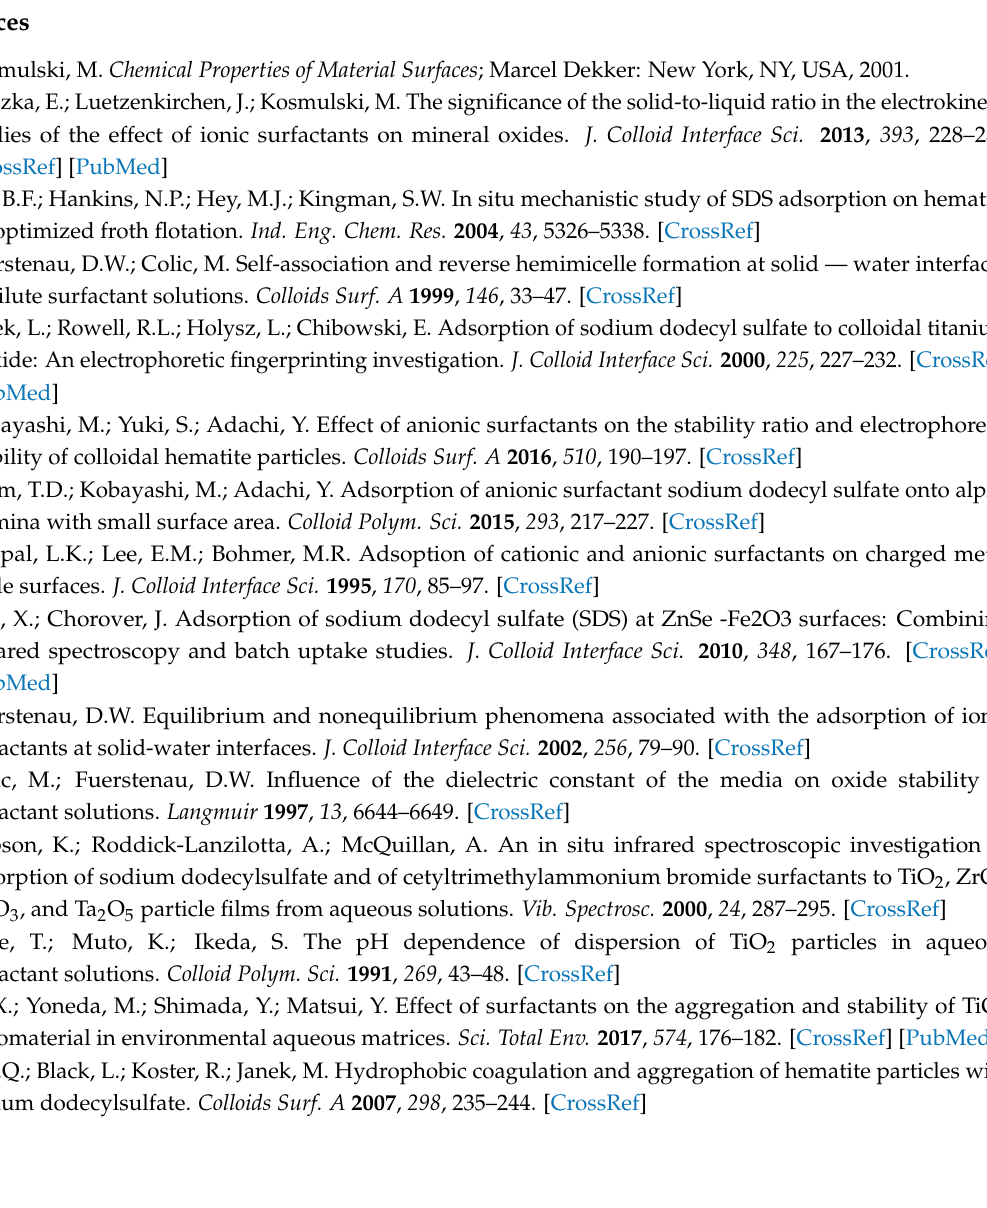
Table S1. The time of aging of dispersions. Table S2. The pH values corresponding to the data points in Figures 9–16. Table S3. The electrophoretic mobilities ( µ , in 10 − 8 m 2 /V/s) corresponding to the data points in Figures